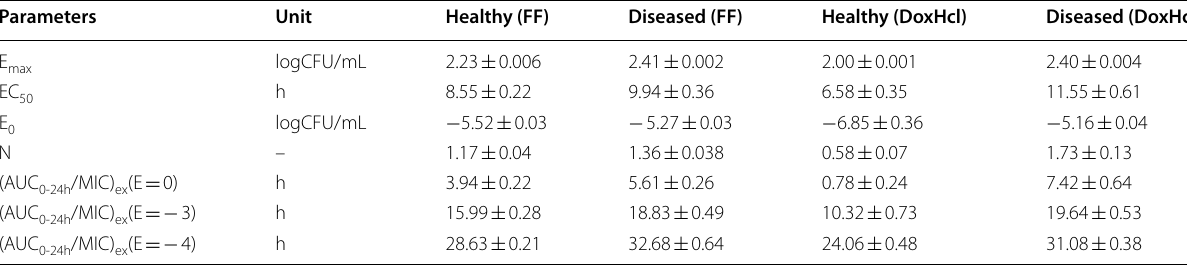
(AUC 24h /MIC) ex E represents the difference of bacteria logarithmic between the initial inoculated bacteria and the alveolar fluid sample at different time points cultivated for 24 h; E 0 represents the difference of bacteria logarithmic between the initial inoculated bacteria and the alveolar fluid sample cultivated for 24 h; E max represents the difference of bacteria logarithmic between the initial inoculated bacteria and the blank alveolar fluid cultivated for 24 h; EC 50 represents the PK-PD parameter in ex vivo when the half of the maximum effect of alveolar fluid sample was produced; N represents the Hill coefficient, describing the PK-PD parameter in the half body and the slope after linearization with the effect of E